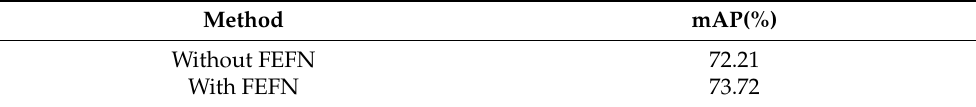
Table 1. Performance of